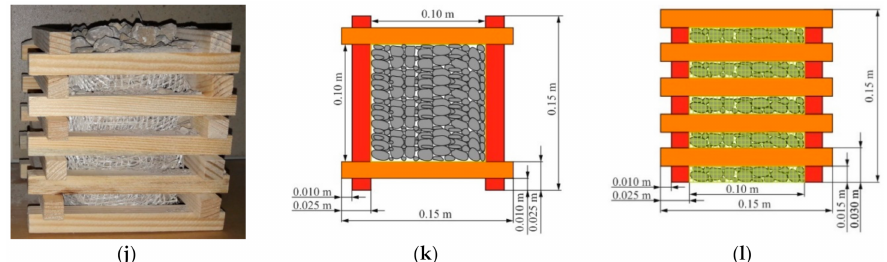
Figure 7. Multi-point cribs: ( a ) Three-point, general view; ( b ) Three-point, top view; ( c ) Three-point, side view; ( d ) Three-point, filled with gangue, general view; ( e ) Three-point, filled with gangue, top view; ( f ) Three-point, filled with gangue, side view; ( g ) Four-point, general view; ( h ) Four-point, top view; ( i ) Four-point, side view; ( j ) Four-point, filled with gangue, general view; ( k ) Four-point filled with gangues, top view; ( l ) Four-point, filled with gangue, side view. The three-point models did not use an internal mesh as the crib beams were adjacent to each other.